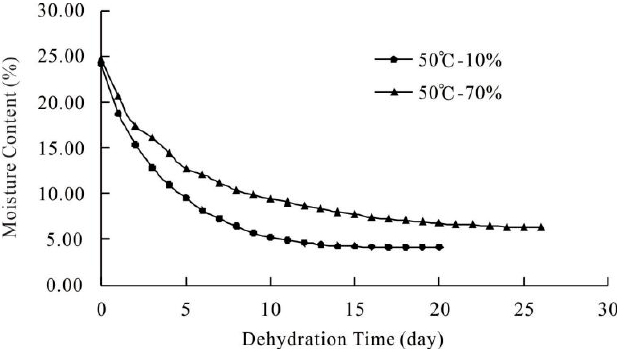
Figure 3. Moisture content of expansive soil varies with dehydration time under different condi- tions.